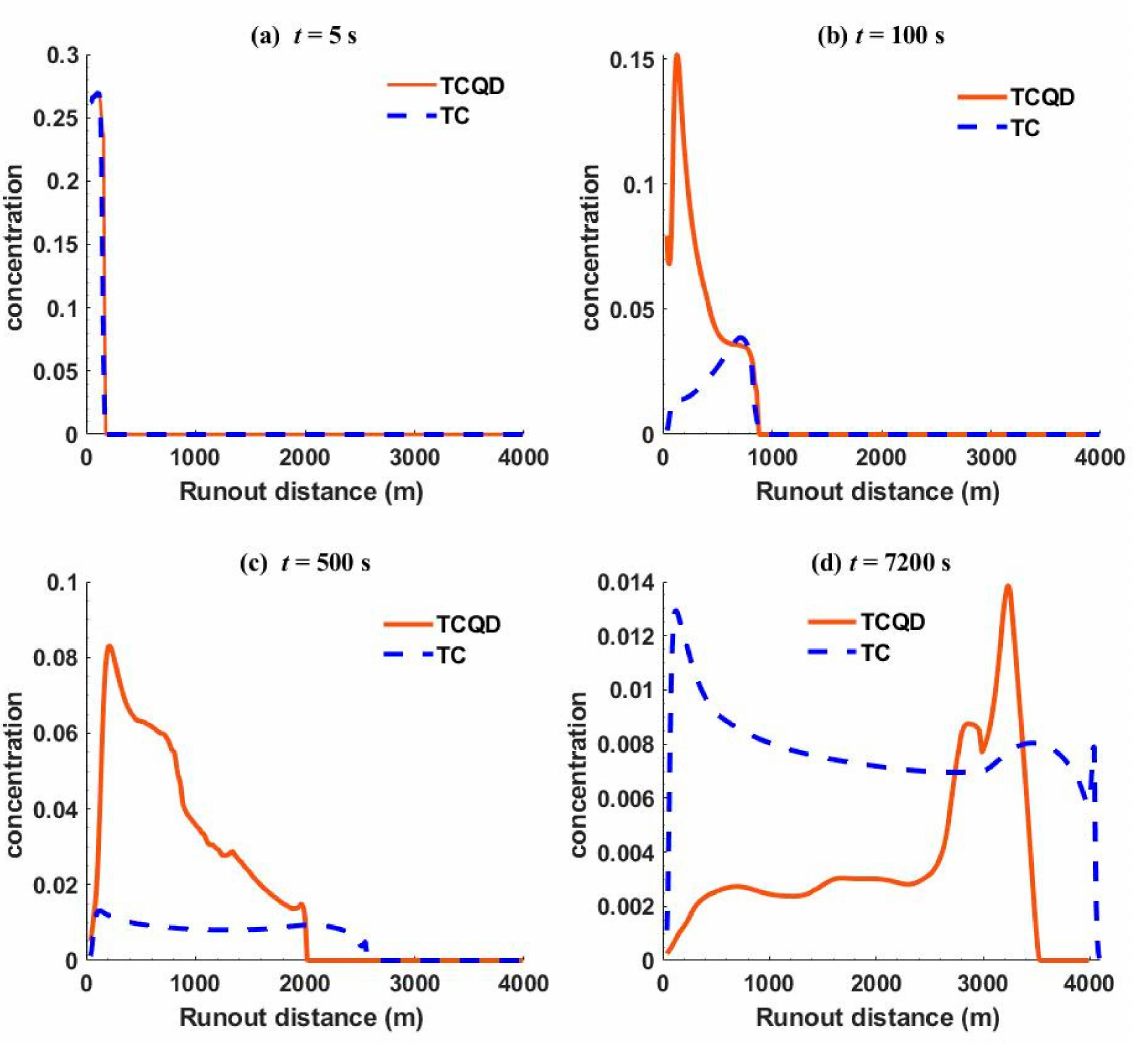
Figure 8. Concentration profiles of TCQD and TC at different times. ( a – d ) show the concentration profiles at 5 s, 100 s, 500 s, and 7200 s,